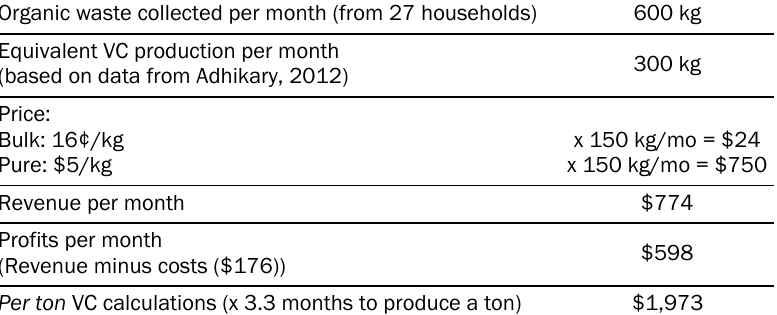
Table 4. Generating Net Returns for a Vermicompost (VC) Enterprise in a Lebanese Case Study